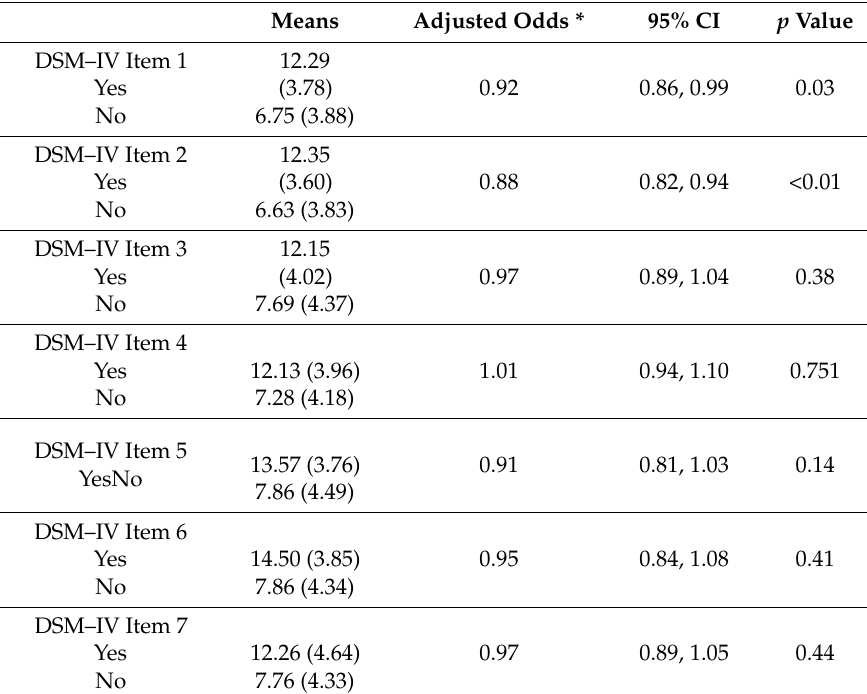
Table 3 showed the discriminant validity of depression in the items. Item 1 (dysphoric mood) and item 2 (loss of interest or pleasure) from DSM–IV and item 8 (brooding, self-pity, or pessimism) from Endicott are the only diagnostic criteria that significantly differentiate the level of depression among the study subjects after having adjusted for the underlying anxiety and distress level. Table 3. Discriminant of depressive symptoms based on HADS-depressive subscale for each item. Depressive Symptoms Based on HADS-Depressive Subscale Means Adjusted Odds * 95% CI p